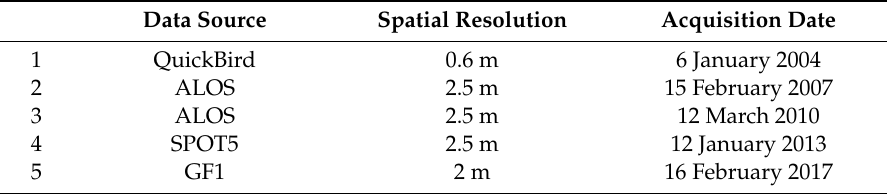
Table 1. The detailed characteristics of the remote sensing